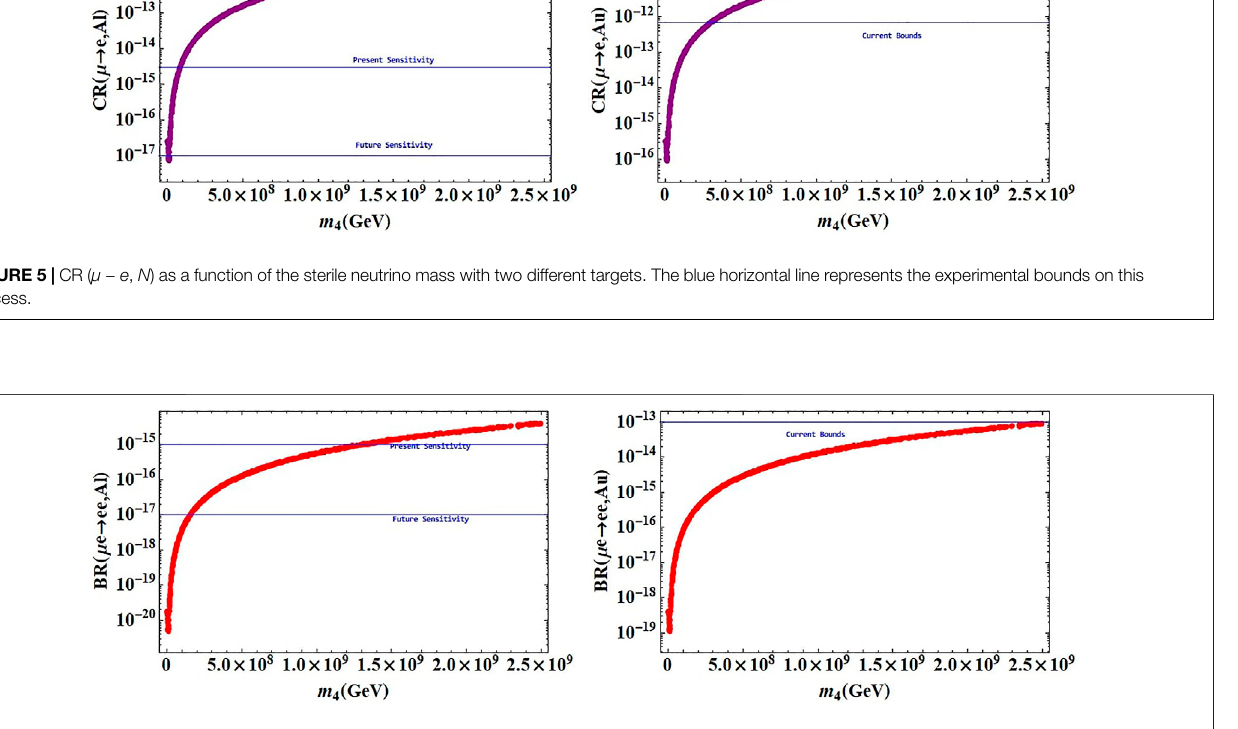
FIGURE6| BR( μ − e − → e − e − , N )asafunctionofthesterileneutrinomasswithtwodifferenttargets.Thebluehorizontallinerepresentstheexperimental bounds on this process.